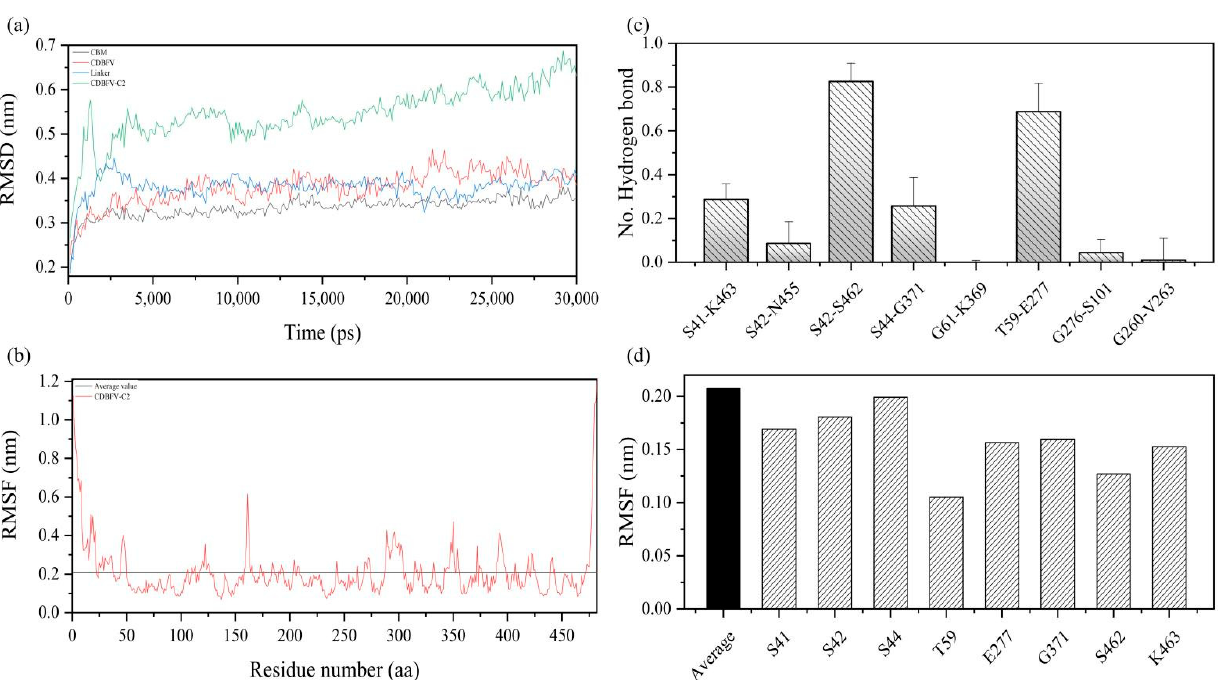
Figure 4. The RMSD, RMSF values, and hydrogen bond stability of the key amino acids of the best chimeric CDBFV-C2. ( a ) RMSD values during a 30.0 ns molecular dynamic simulation of the best chimeric xylanase CDBFV-C2 and its compo- nents. ( b ) RMSF values of residues from the best chimeric xylanase CDBFV-C2. The horizontal line represents the average RMSF of all amino acids of the best chimeric xylanase CDBFV-C2. ( c ) The probability of hydrogen bond formation during a 30.0 ns molecular dynamics simulation of the best. chimeric xylanase CDBFV-C2 with eight additional hydrogen bonds. ( d ) RMSD values during a 30.0 ns molecular dynamics simulation of the key amino acid residues of the stable hydrogen